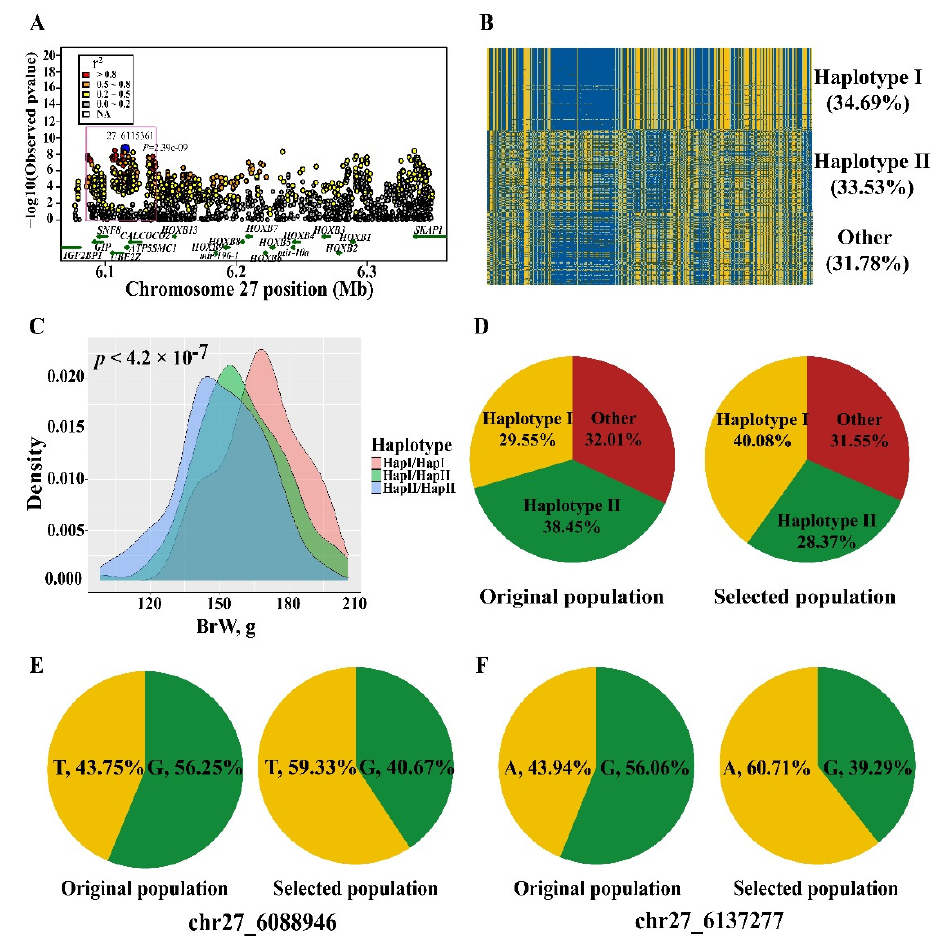
Figure 5. Haplotype association analysis and frequency difference in original and selected popula- tions. ( A ) A refined genomic region was identified by r 2 > 0.8 and 2-LOD drop-off method, namely the pink box. ( B ) Distribution of two major haplotypes (I and II) in JX chicken. ( C ) The effect of major haplotypes on BrW, the haplotype I has an increasing effect on BrW. ( D ) The frequency of two major haplotype (I and II) in original and selected population. ( E , F ) The frequency of two conserved sites (chr27_6088946 and chr27_6137277) in original and selected population.